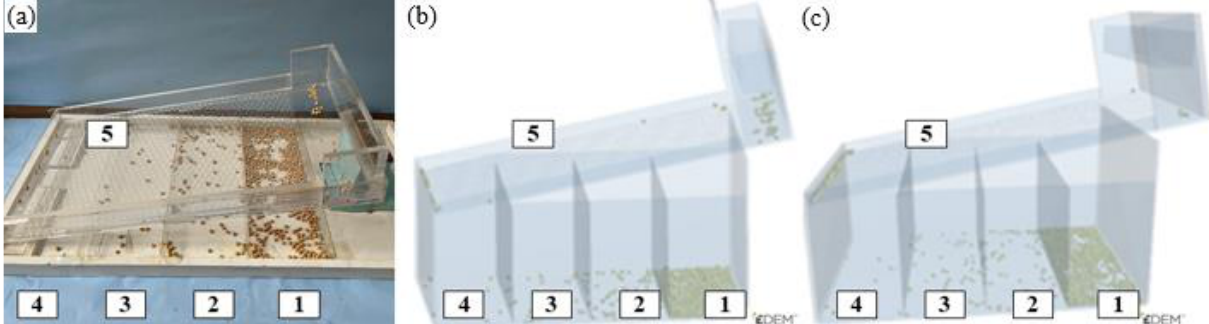
Figure 20. ( a ) The test photo, ( b ) the simulation screenshot using the calibrated parameters, and ( c ) the simulation screenshot without considering the rolling friction coefficient for self-flow screening test.